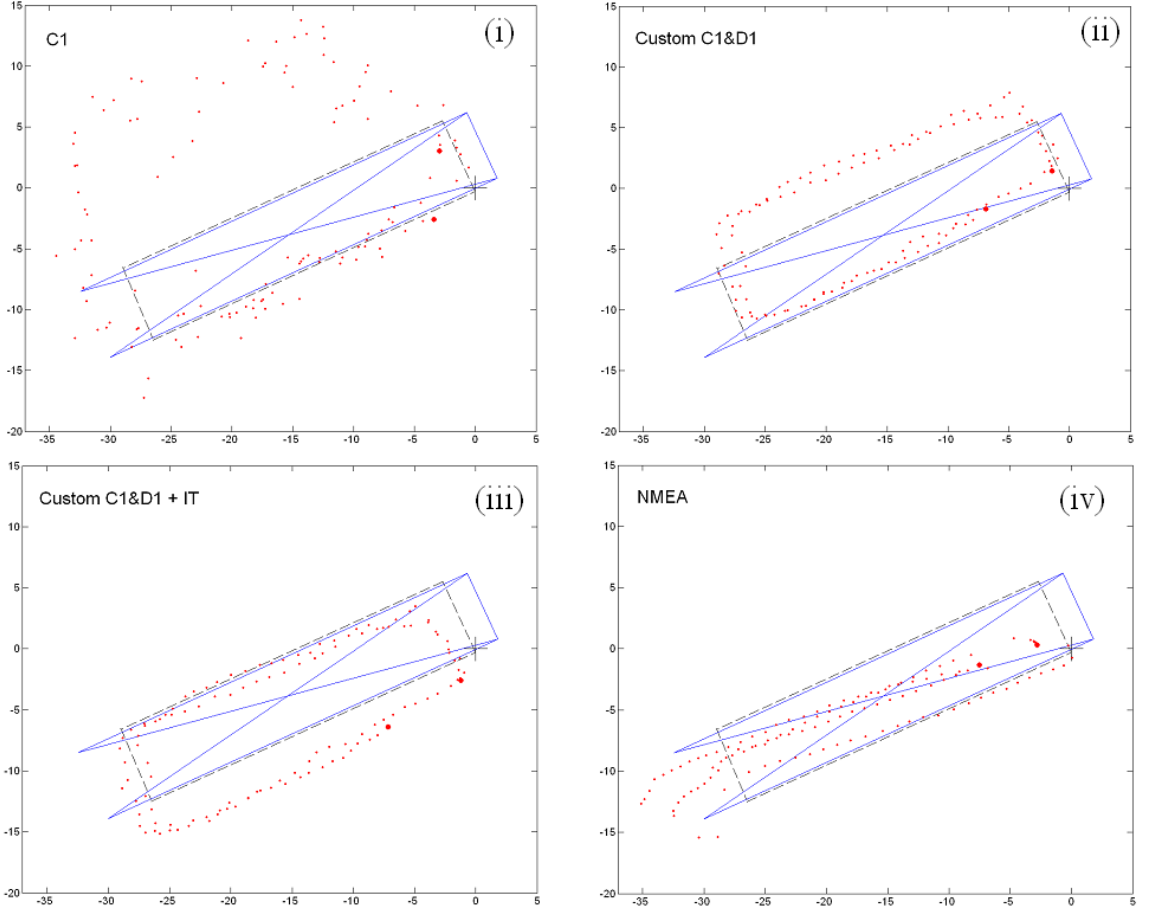
Figure 10. Solutions under adverse conditions (f): (i) autonomous code positioning; (ii) custom positioning procedure with C1&D1; (iii) custom positioning procedure with C1&D1, plus ionosphere and troposphere models; (iv) internal positioning of the receiver. Units are in